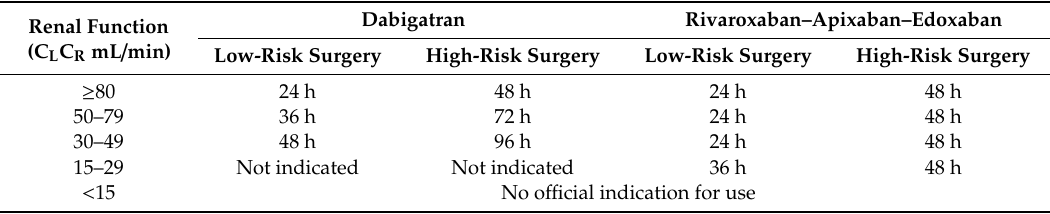
Table 6. Interruption of DOAC therapy before oral surgery.